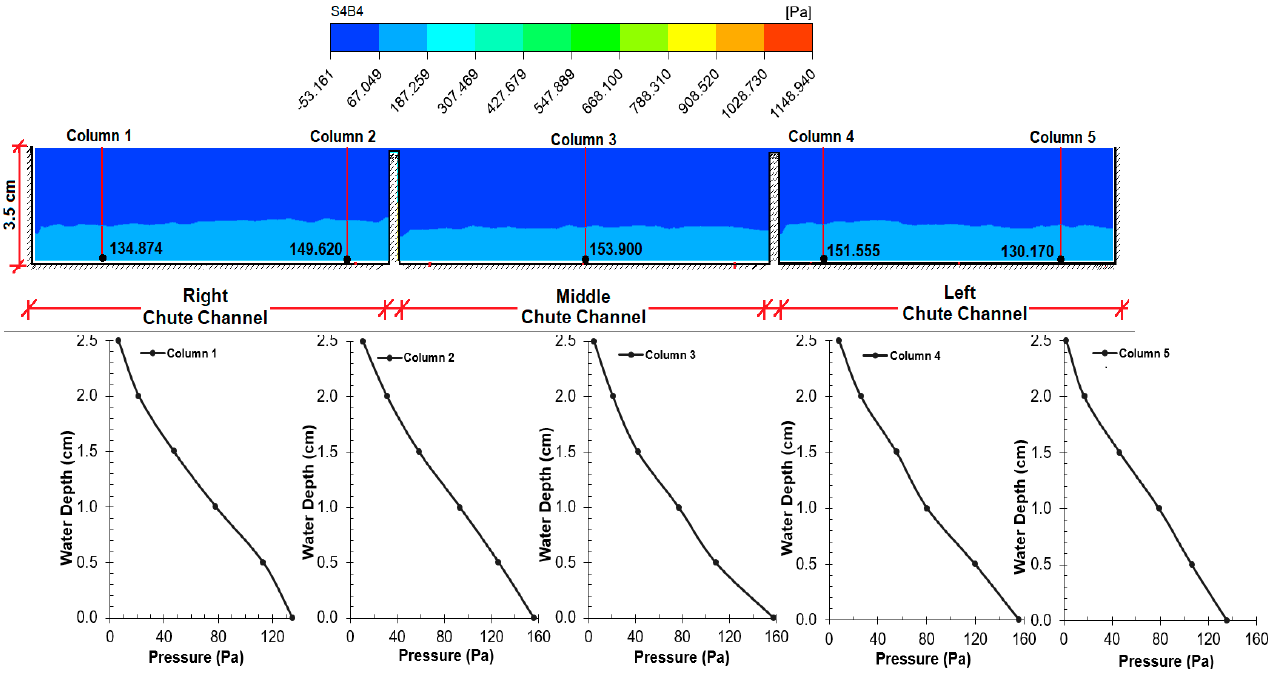
Figure 28. CFD pressure contours and depth-pressure distributions for Cross-section 4.